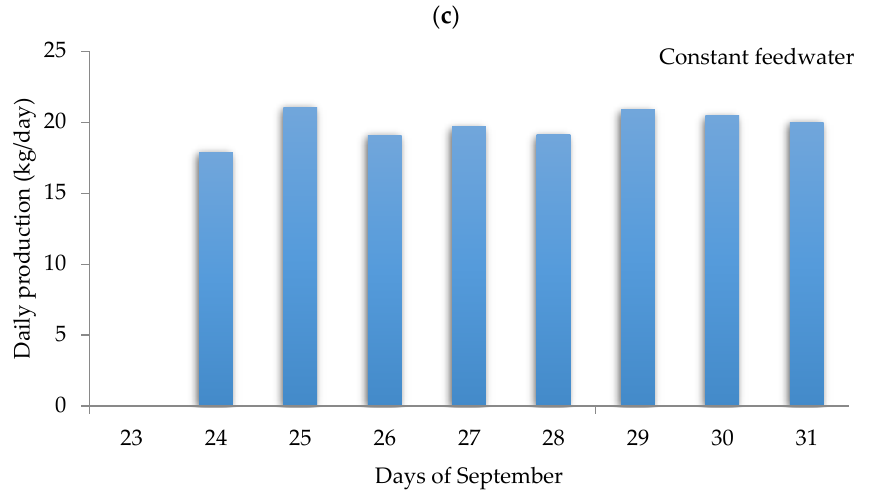
Figure 7. ( a ) Measured solar radiation, ( b ) medium fluid supply temperature, and ( c ) daily distillate production.